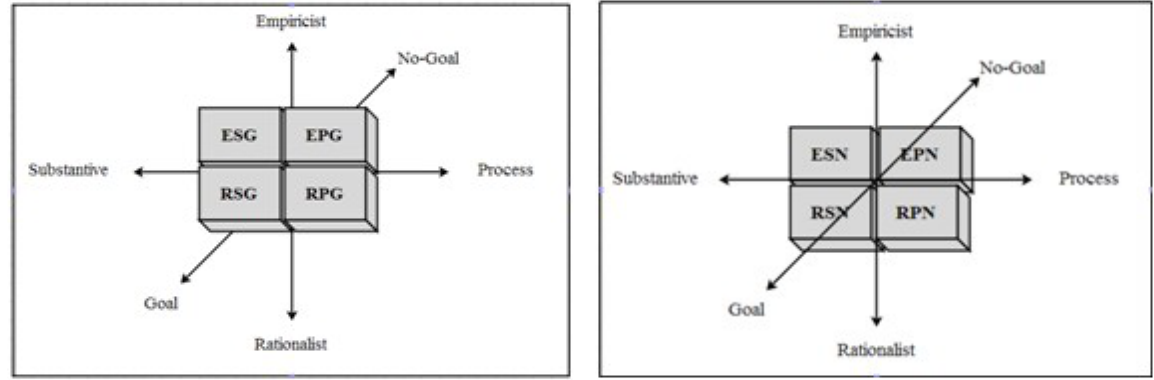
Figure 1. The PPI structure 1 Figure 2. The PPI Structure